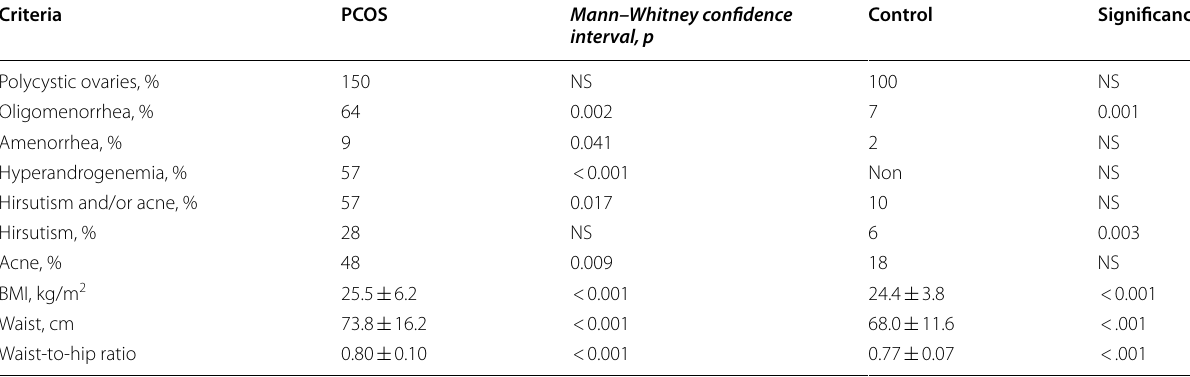
NS non-significant